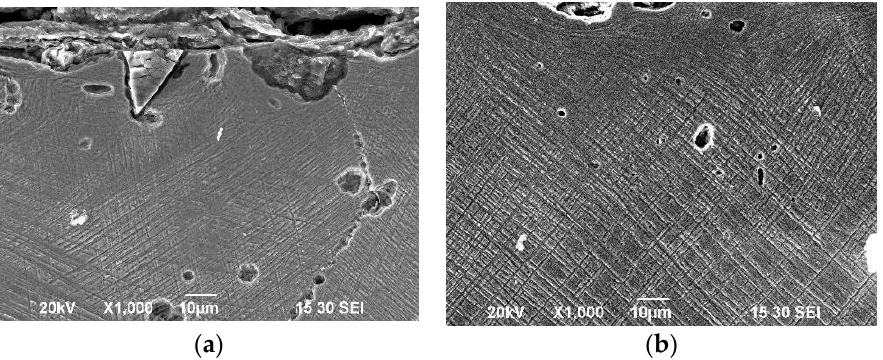
Figure 5. Microstructure of 0.175%V high manganese steel surface subjected to impact-abrasion wear: ( а ) as cast; ( b ) after heat treatment.